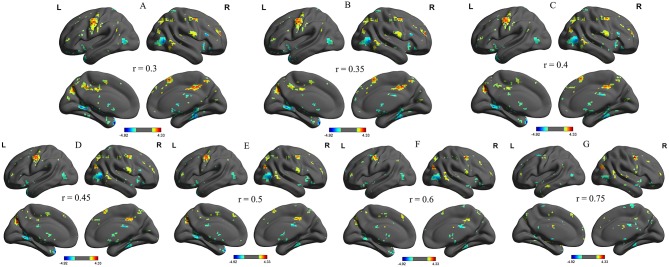
Binarized shortFCD maps with several thresholds between alcohol dependent and healthy subjects. We analyzed binarized shortFCD differences between alcohol dependent and healthy controls across seven different r-value thresholds (A, r = 0.30; B, 0.35; C, 0.40; D, 0.45; E, 0.50; F, 0.6; G, 0.75). Red color, increased binarized longFCD areas; Blue color, decreased binarized longFCD areas. R, right; L, left; shortFCD, Short-range FCD.